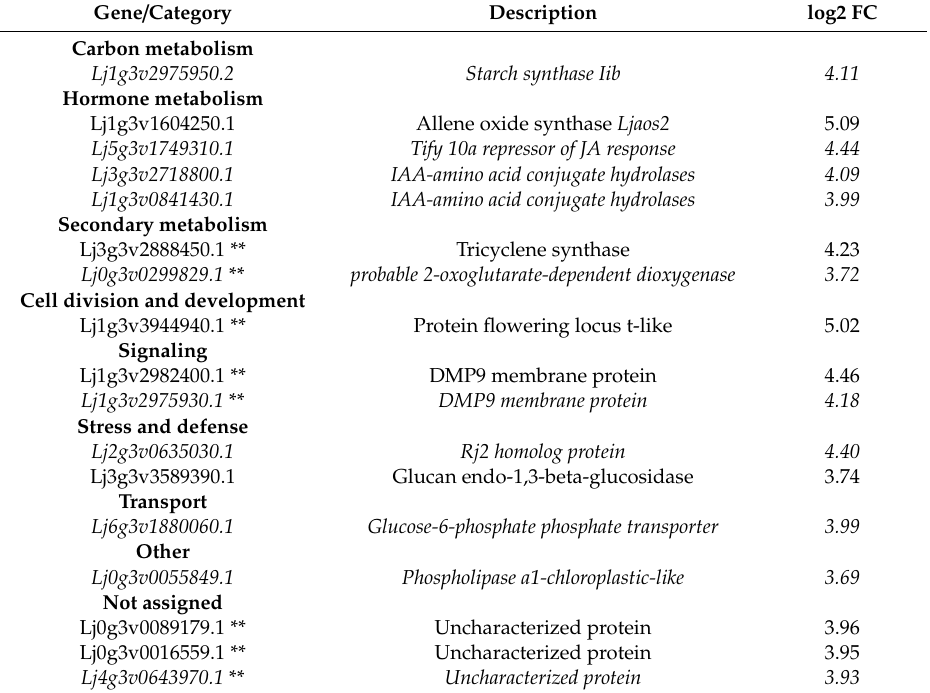
Table 3. Genes upregulated in shoot of Nod plants compared to shoot of NN plants. The fold change (FC) in expression levels is expressed as the log 2 of the di ff erence in relative expression levels of Nod–NN. Genes without a previously proposed role in nodule function and / or development are highlighted with two asterisks. Italic font is used to highlight the genes from the left cluster of Figure